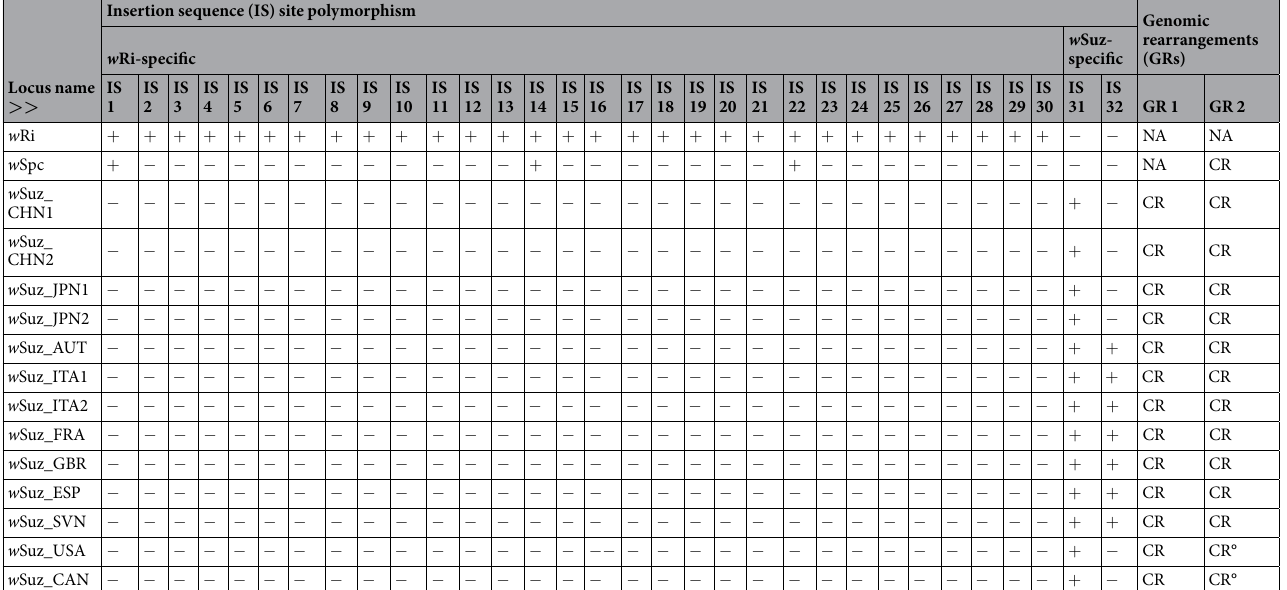
Table 2. Diagonostic PCR screening of Insertion sequence (IS) site polymorphism and genomic rearrangements (GRs) based markers. ῾ + ’ sign indicates presence and῾ − ’ indicates absence of the IS element. Bold letters indicate IS loci shared by w Ri and w Spc, NA- No amplification, CR- Chromosomal rearrangement. CR°- Chromosomal rearrangement with size